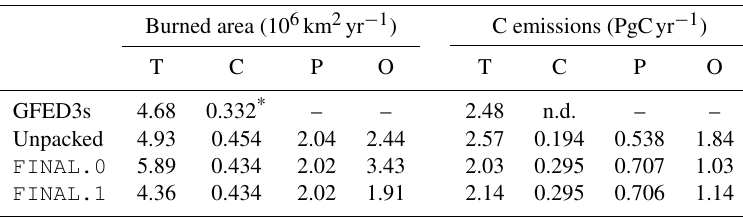
Figure 6. Absolute error in mean annual burned fraction (a–d) and fire carbon emissions (e–h) for each land cover type: model-estimated minus observational estimates from unpacking analysis. Table 4. Global mean annual burned area and associated carbon emissions, 2001–2009. FINAL.0 and FINAL.1 refer to experimental runs (Table 2) with Optimization 3 (Table 3). T: total; C: cropland; P: pasture; O: other